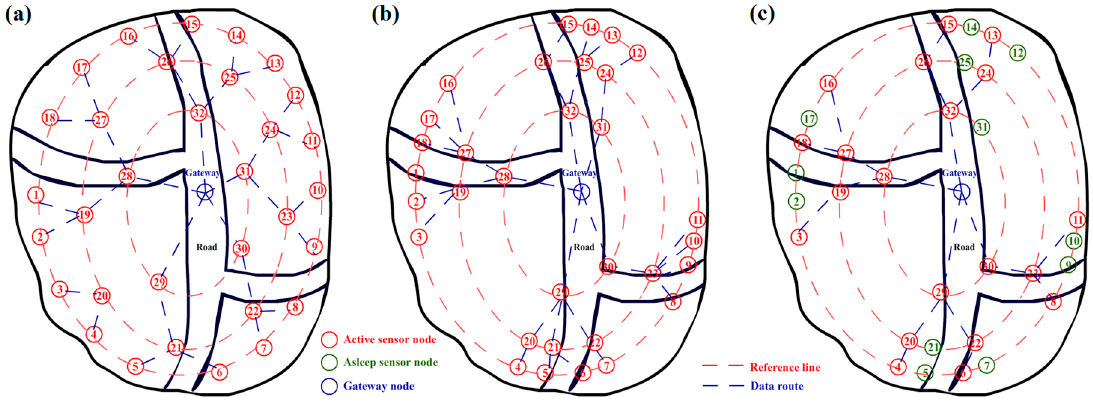
Figure 1. ( a ) Illustration of the initial arrangement of sensor nodes for a detection system; ( b ) illustration of the new arrangement of sensor nodes after adaptive learning and movement; and ( c ) active sensor nodes after representative nodes are selected for energy savings.